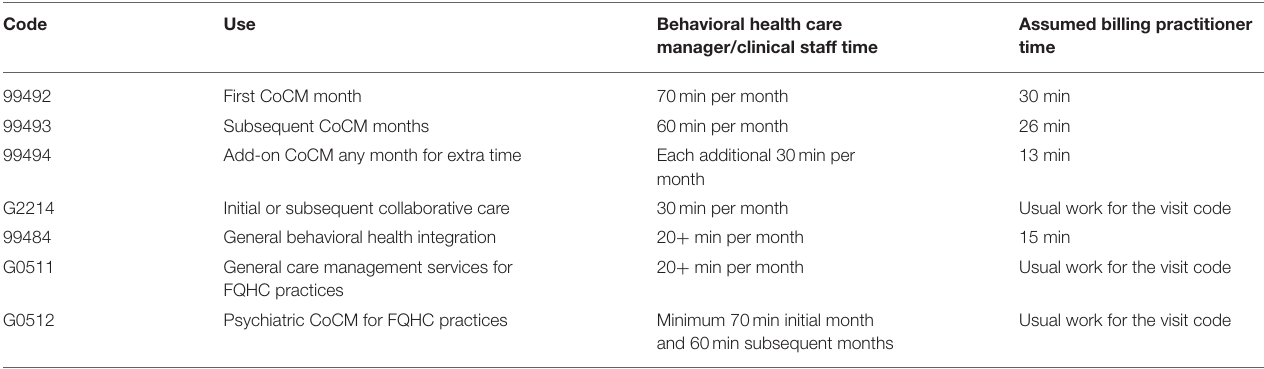
TABLE 3 | United States integrated team-based reimbursement